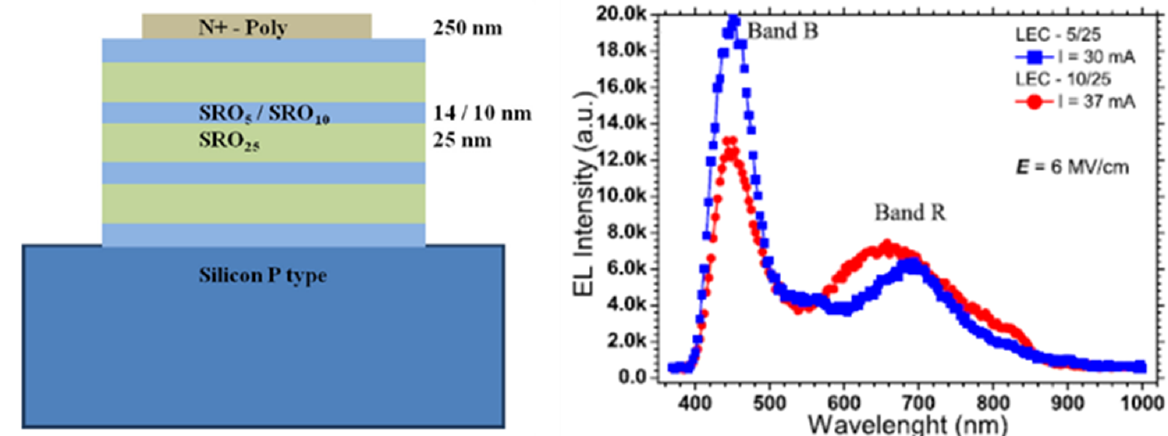
Figure 4. Schematic ( left ) and EL spectra ( right ) of multilayered structure made of nanolayers of R 0 =25 and R 0 = 10. R 0 = 10 or 5 improves the conduction properties, and R 0 = 25 is used because of high emission properties [31].